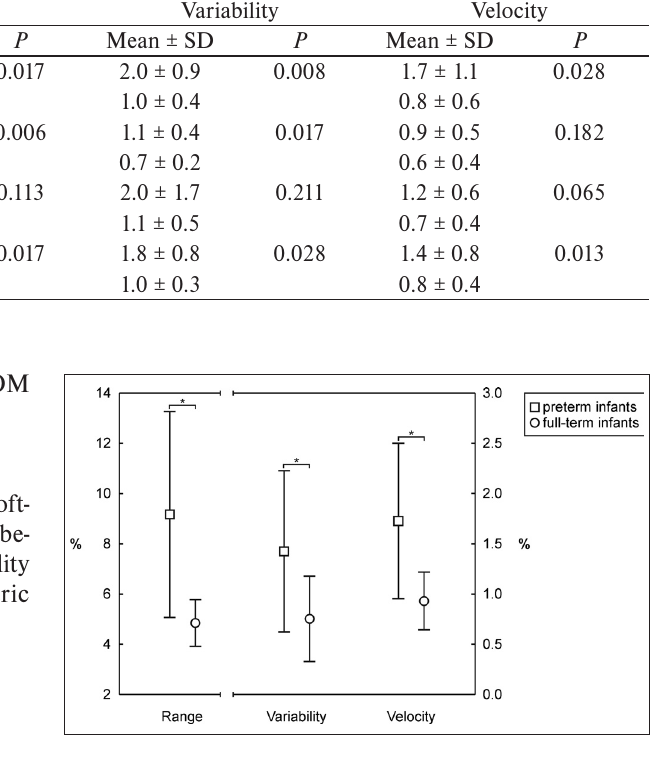
Fig. 1. Graphical comparison of observed groups – 3D values. * P < 0.05